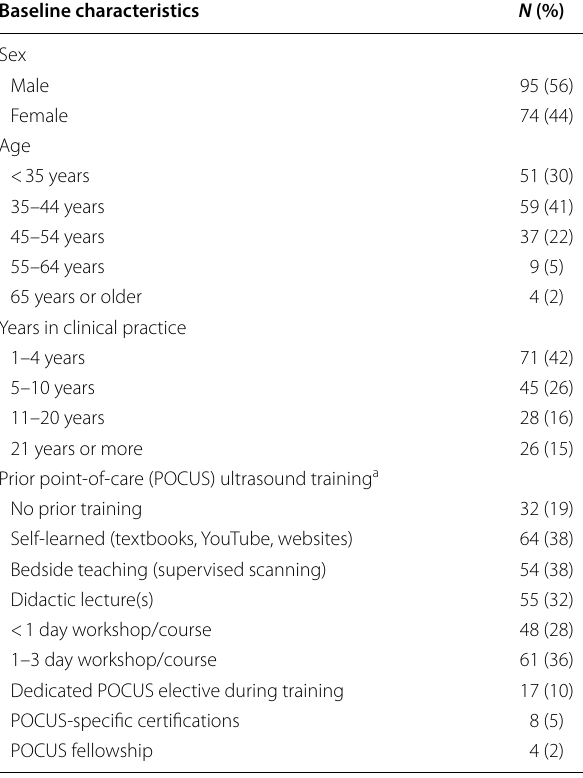
Table 1 Baseline characteristics of 170 participants who completed the